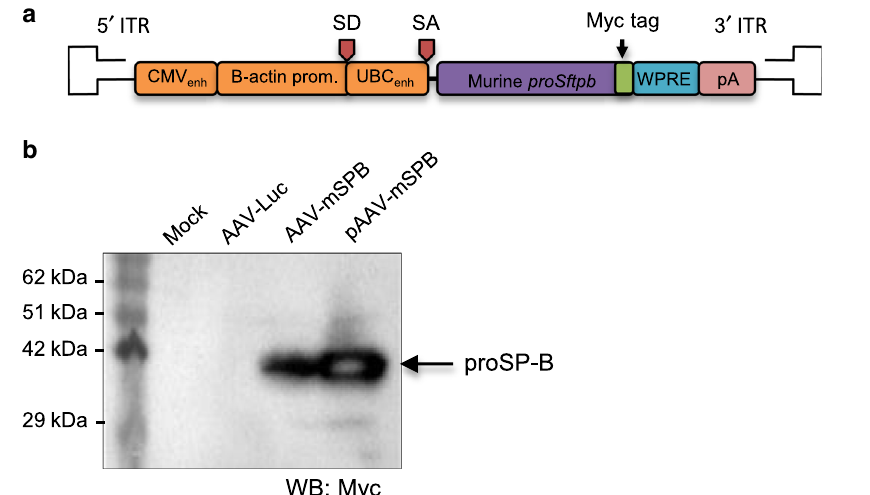
Fig. 3 Generation of AAV6.2FF murine proSftpb cDNA (AAV-mSPB). a Schematic of codon optimized murine proSftpb cDNA transgene in the rAAV2 vector genome. A myc tag is attached to the C-terminal end of the proSftpb sequence. b Western blot of cell lysates from HEK293 cells transduced with AAV6.2FF-murine proSftpb cDNA (AAV-mSPB) at a Multiplicity of Infection (MOI) of 20,000 or transiently transfected with a proSftpb expression plasmid (pAAV-mSPB), probed with an anti-myc-tag antibody. The expression of proSP-B protein is indicated by an arrow. The source data for b has been provided as a Source Data fi